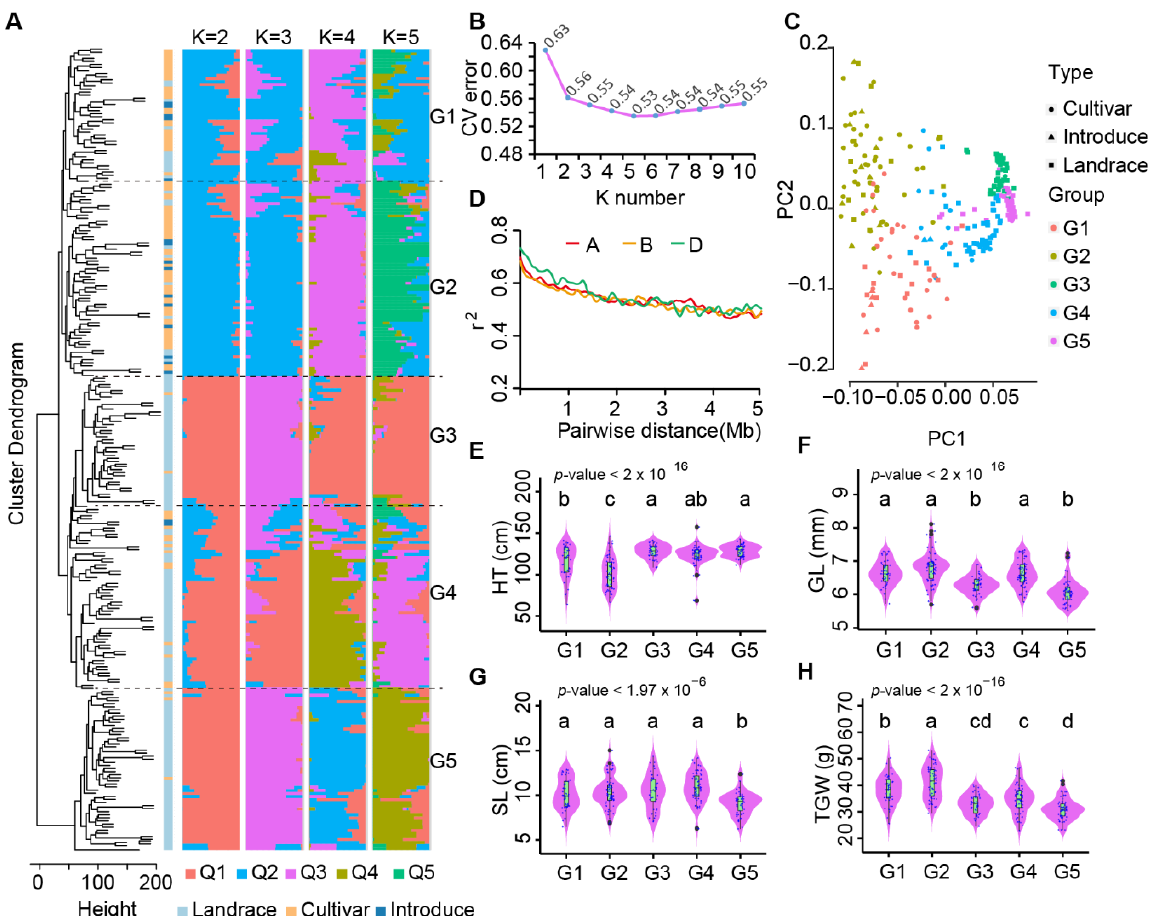
Figure 2. Population structure of the Chinese wheat mini-core collection using InDels. ( A ) Cluster dendrogram (left) and STRUCTURE (right) analysis separated cultivars from landraces mainly. ( B ) The cross validation (CV) error between sub-populations. The CV error between sub-populations was the lowest when the population was divided into five sub-population. ( C ) Principal components analysis (PCA) plot for all accessions. ( D ) Decay of linkage disequilibrium (LD) in the three sub-genomes. ( E – H ) Phenotypic differences between subpopulations. p -value for F statistics in ANOVA was marked in the upper left of the panel. The Tukey’s HSD test results were shown above the violin plot. There were significant differences between groups with different letters ( p -value < 0.05).